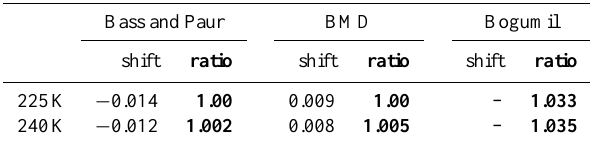
Table 4. Direct comparison of SCIAMACHY FM revised data to literature data using a non-linear least square fitting programme in the DOAS fitting window (325–335nm). The scaling factor (dis- played in bold) and wavelength shifts presented here are the ones that should be applied to the revised SCIAMACHY data in order to match the reference